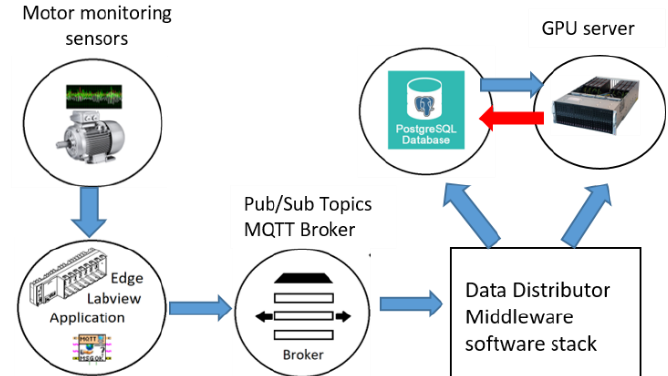
Figure 7. An IoT data pipeline utilized to collect data from the testbed and store sensor data in databases on a GPU